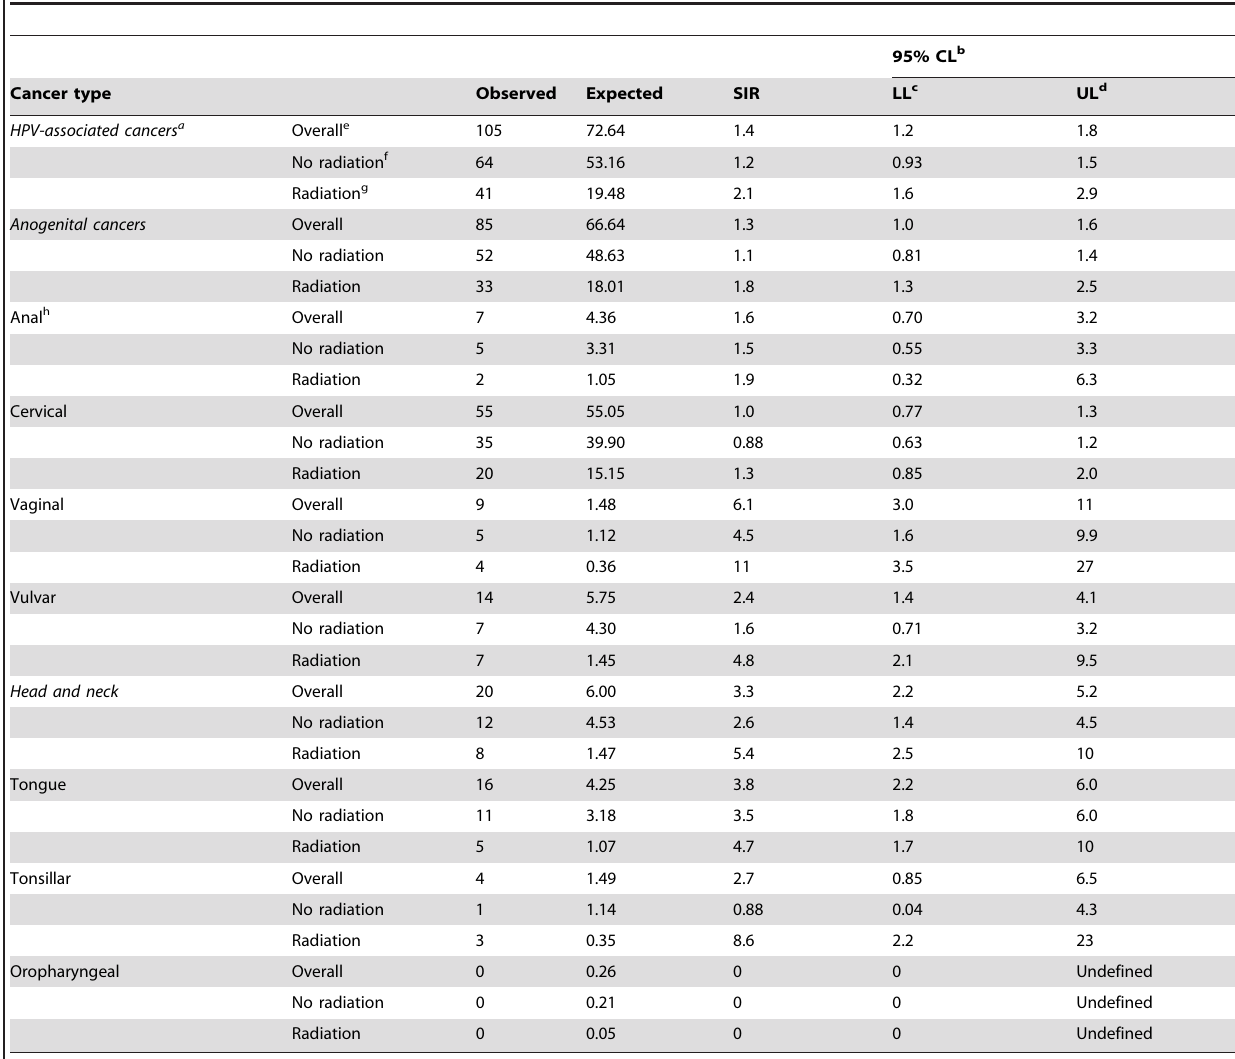
Table 2. Standardized incidence ratios (SIRs) for human papillomavirus (HPV)-associated malignancies among female survivors of pediatric and young adult (PAYA) cancers, 1973 to